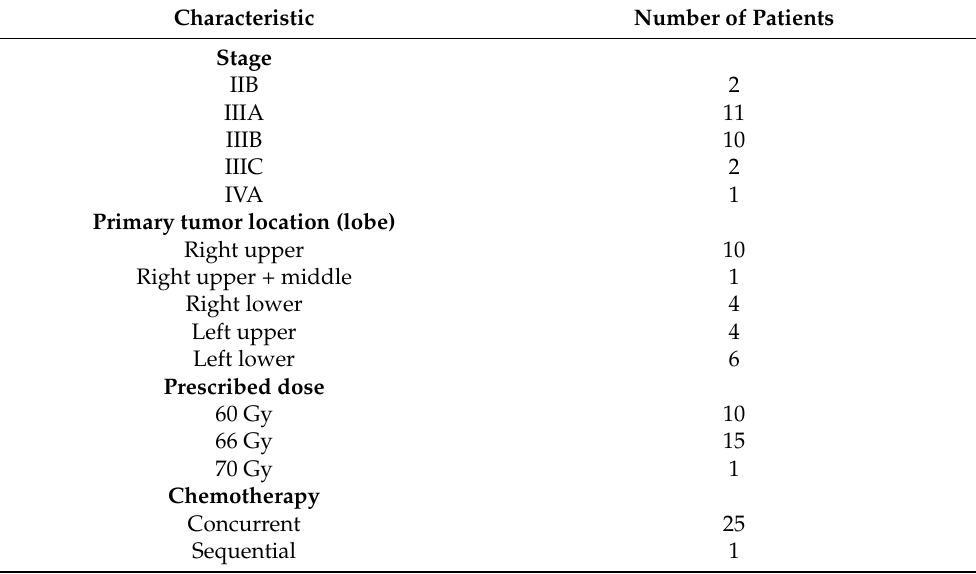
Table 4. Patient and treatment characteristics.